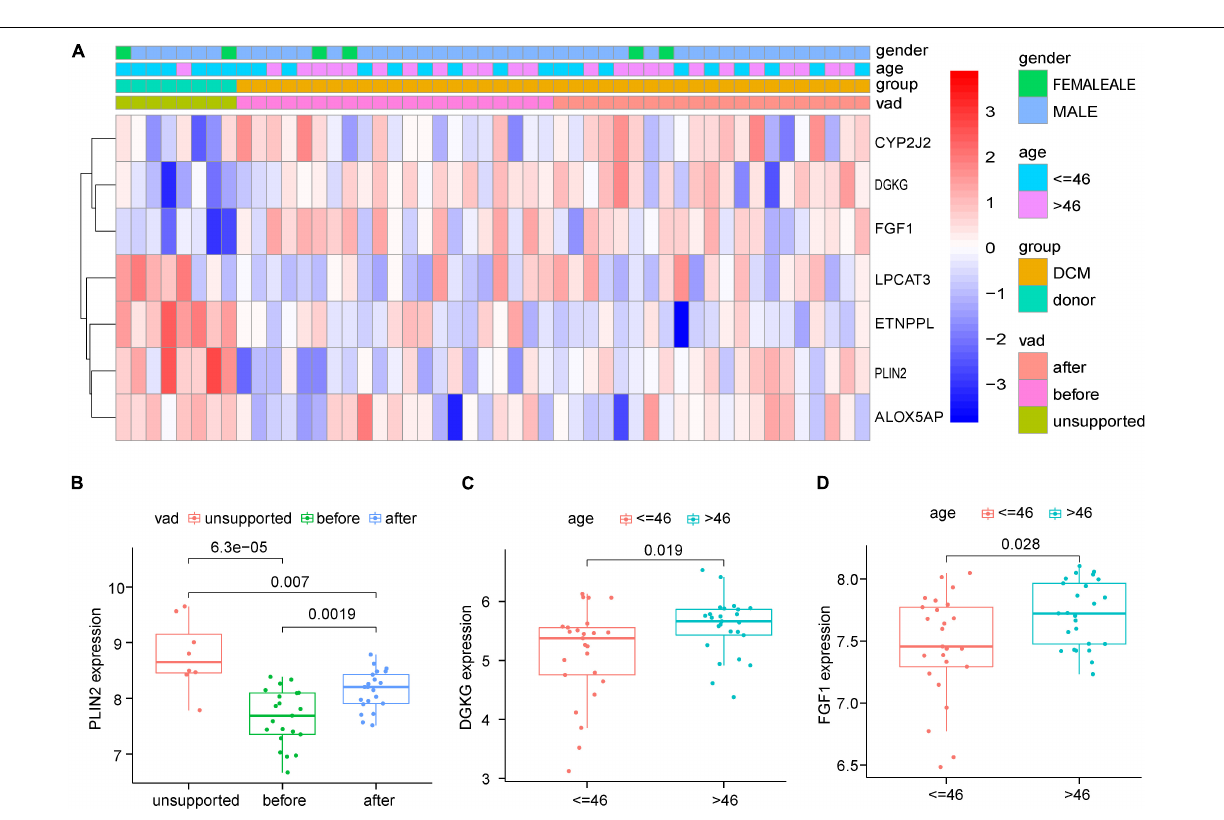
FIGURE 5 | Correlation analysis based on Clinical informations and expression profiles of the 7 DELs in GSE21610. (A) Heatmap of correlation analysis. (B) The expression levels of PLIN2 were significantly upregulated after VAD supported. (C,D) The expression levels of DGKG and FGF1 were significantly upregulated in elder group ( > 46